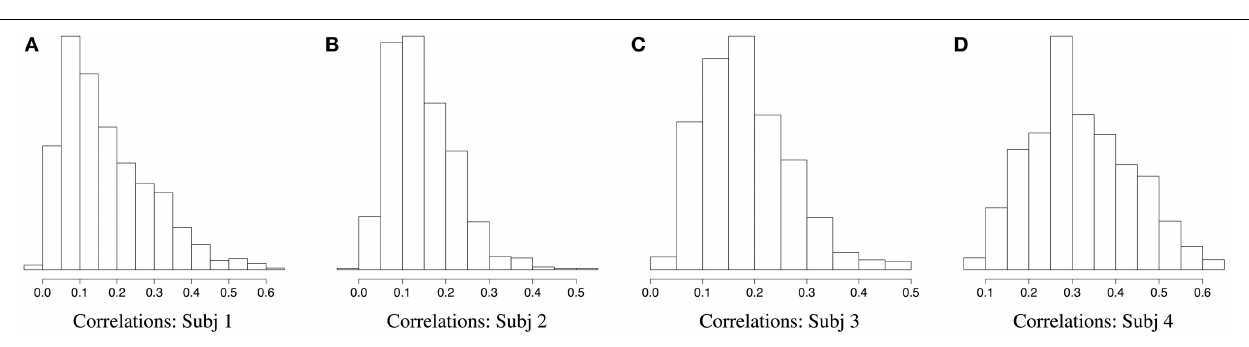
FIGURE 4 | Histograms of correlations between bands across all cortical ROIs for four subjects.